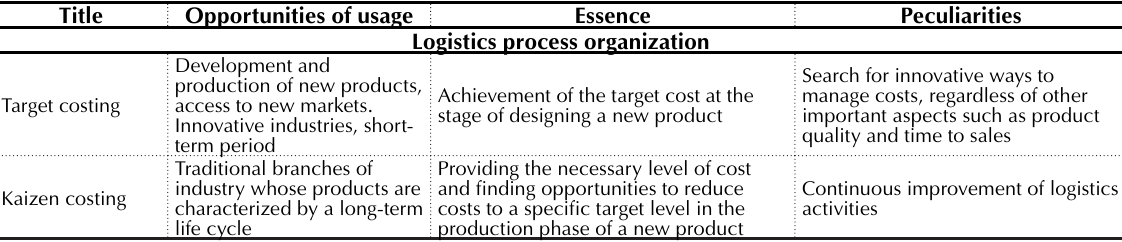
Table 2 (cont.). Logistics costs accounting